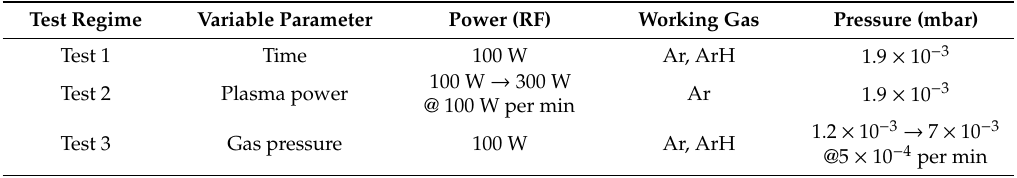
Table 1. The experimental regime conducted to obtain the spectral results from the plasma light source under various conditions in 3 separate test groups. Test 1: where the stability of the plasma was monitored at 100 W under 1.9 × 10 − 3 mbar of working gas pressure, under Ar and ArH gas; Test 2: The spectral emission of the plasma was monitored while increasing the power of stabilized plasma from 100 to 300 W under 1.9 × 10 − 3 mbar of Ar; Test 3: The spectral emission of an stabilized plasma was monitored at 100 W plasma power under various Ar and ArH gas pressures. (Note: separate spectral analysis of the plasma power was carried out up to 350